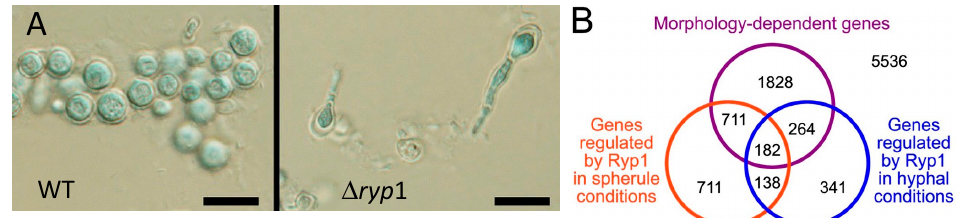
Figure 13. ( A ). Wildtype and ∆ ryp 1 C. posadasii grown in Converse medium in spherule conditions. Spherules form in the WT organism; only hyphae with polar swelling but no spherules are seen in the ∆ ryp 1 C. posadasii mutant. The bars represent 10 µ M. ( B ). Gene expression in the ∆ ryp 1 mutant. Morphology-dependent genes; genes differentially expressed in spherules compared to mycelia Theses figures are from [153].